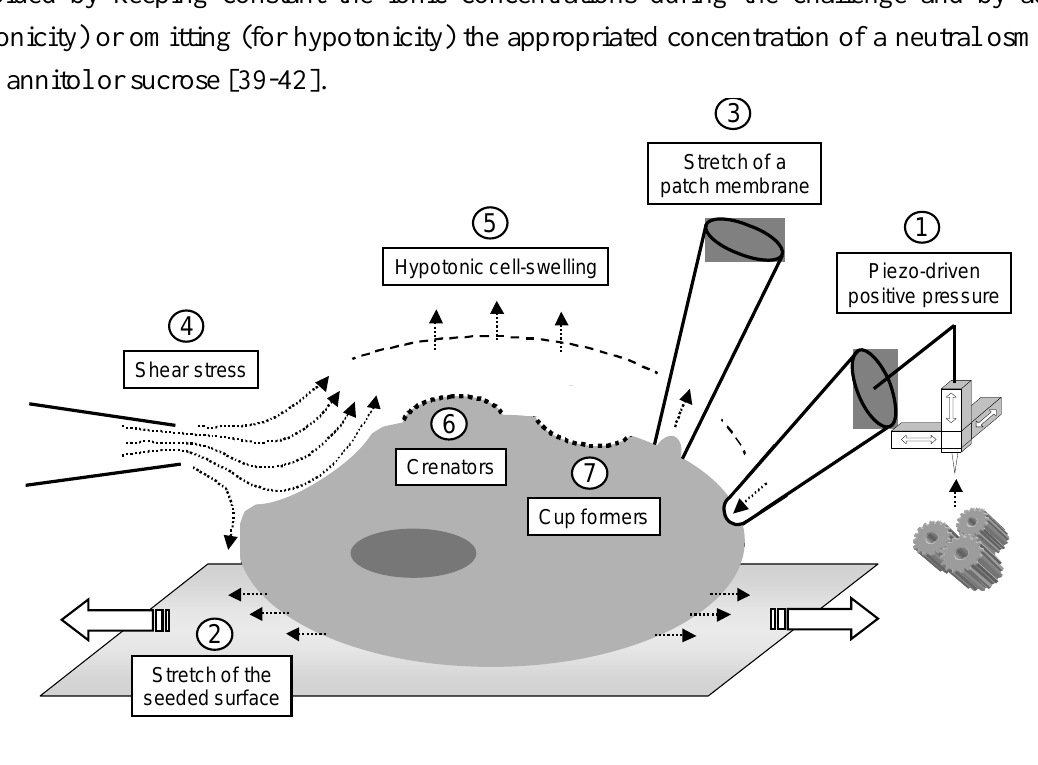
Figure 1. Diagrammatic representation of strategies used to cause